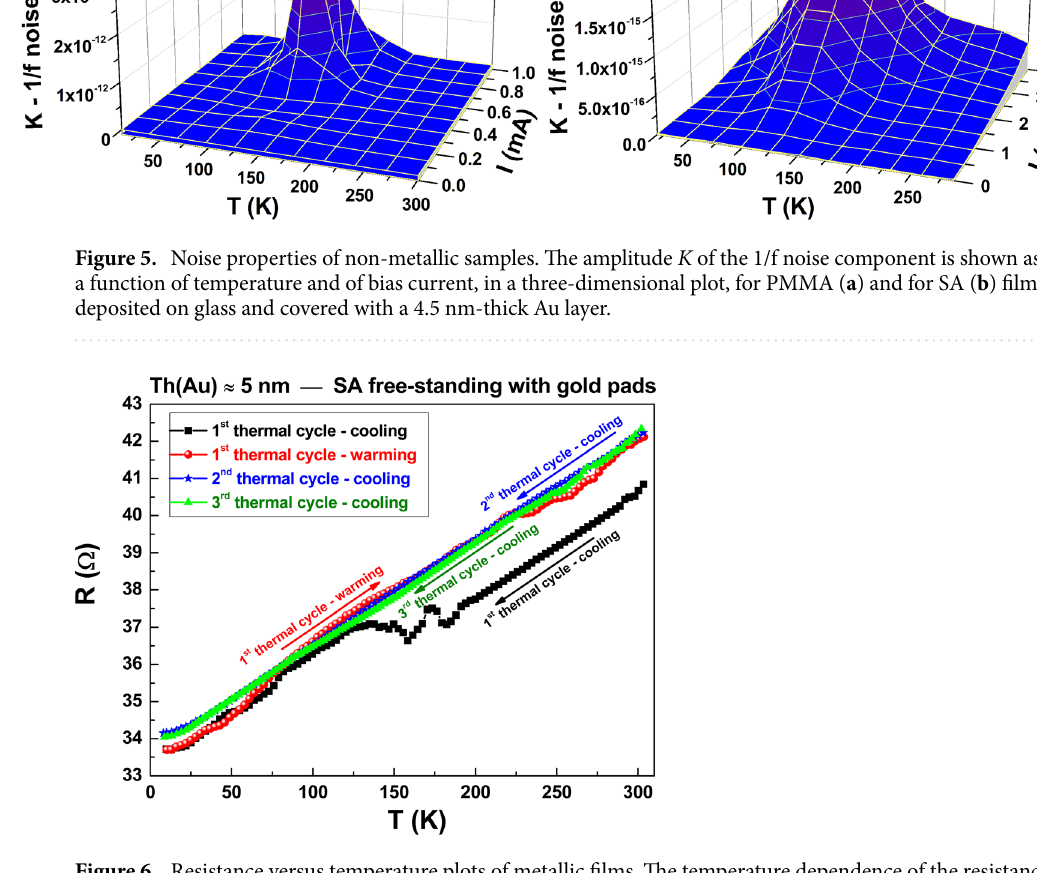
Figure 6. Resistance versus temperature plots of metallic films. The temperature dependence of the resistance R is shown for SA free-standing films covered with a 5 nm-thick Au layer. The results, obtained on samples electrically contacted with Au pads, are reported for subsequent thermal